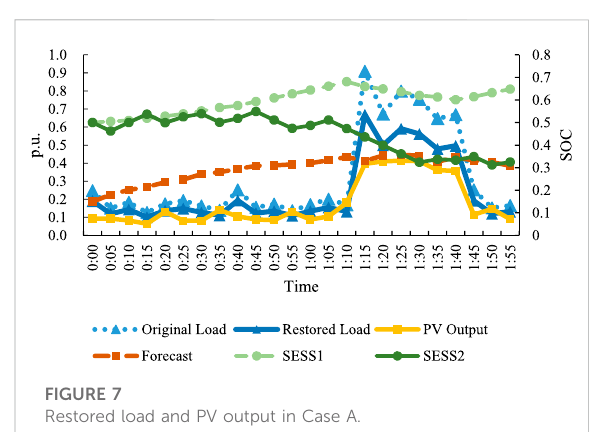
FIGURE 7 Restored load and PV output in Case